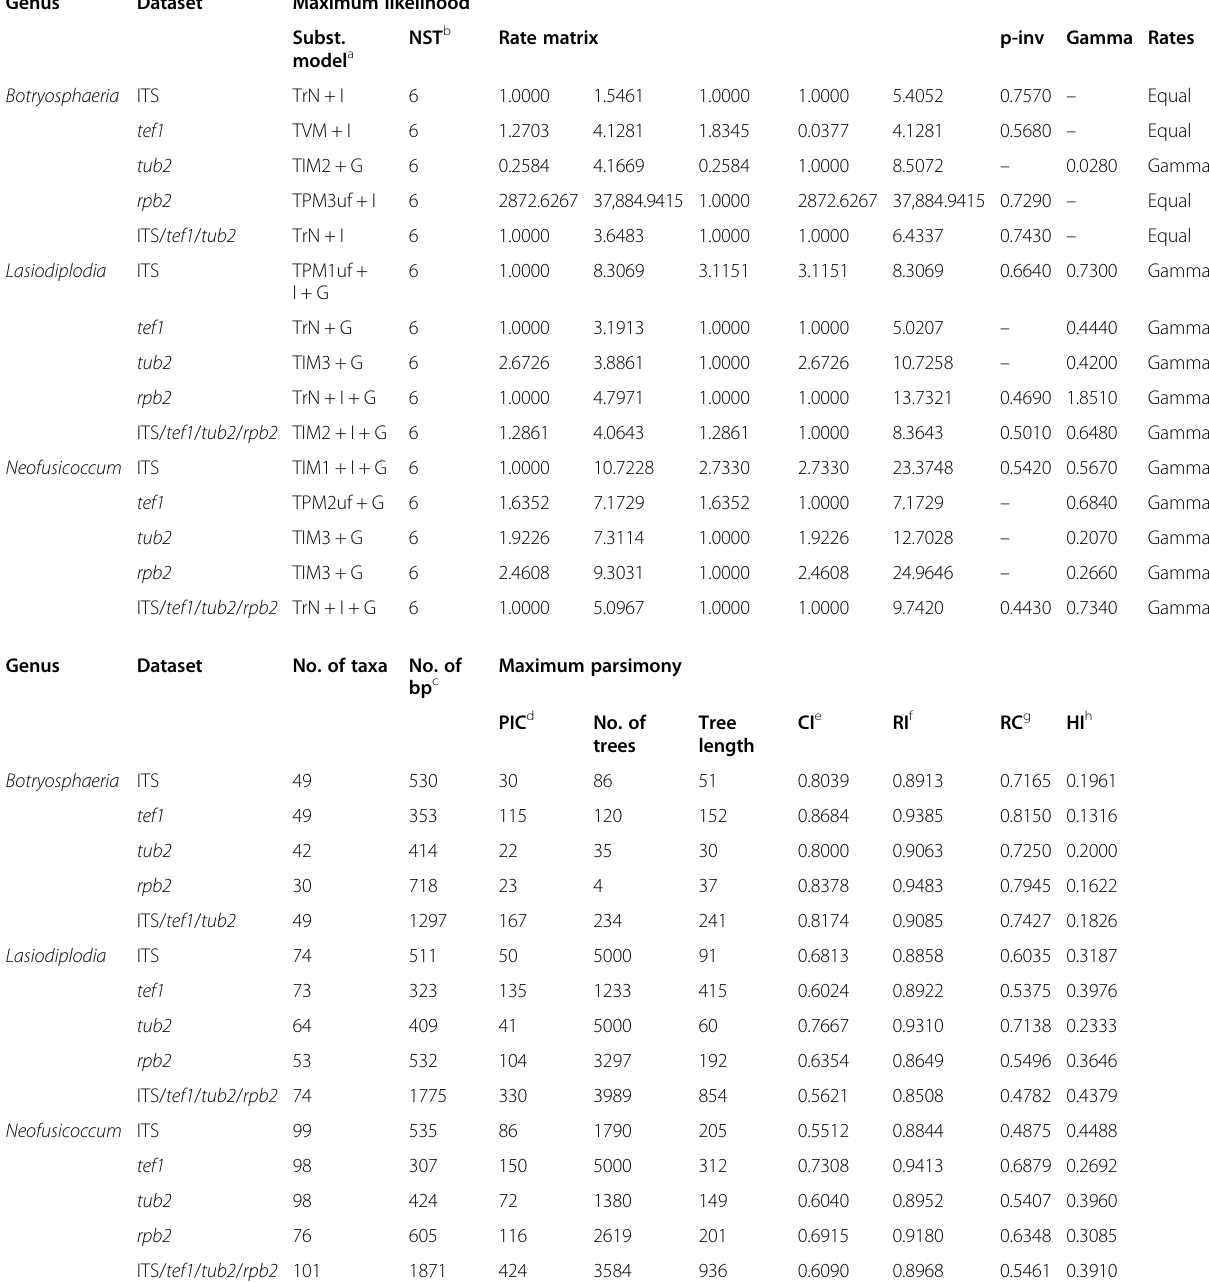
Table 3 Statistical values of datasets for maximum parsimony and maximum likelihood analyses